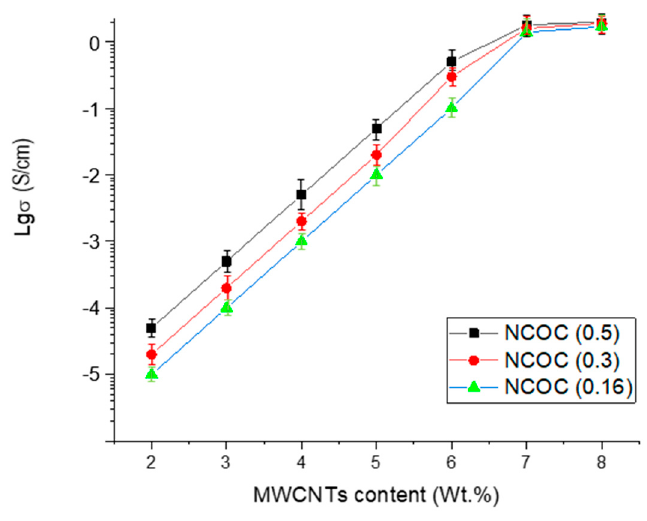
Figure 8. The dependence of electrical conductivity from MWCNTs content in elastomer. The change in the heat release power P(T) 7 can be described by the temperature de- pendence for samples with a mass concentration of MWCNTs equal to 7 and 8% as 𝑃(𝑇) = 7 − 20 × 10 (cid:2879)(cid:2870) 𝑇 + 5 × 10 (cid:2879)(cid:2871) 𝑇 (cid:2870) − 3 × 10 (cid:2879)(cid:2873) 𝑇 (cid:2871) (cid:2875) and 𝑃(𝑇) (cid:2876) = 8.5 − 20 × 10 (cid:2879)(cid:2870) 𝑇 + 7 × 10 (cid:2879)(cid:2871) 𝑇 (cid:2870) − 2 × 10 (cid:2879)(cid:2873) 𝑇 (cid:2871) respectively. The application of a nano-modified elastomer requires an analysis of the temperature processes occurring during its heating (Figure 9). Figure 9. DSC of nano-modified elastomer. The heating process of the nanomodified elastomer clearly proceeds without any changes at temperatures up to 200 °C. Further heating up to 400 °C is accompanied by a phase transition.